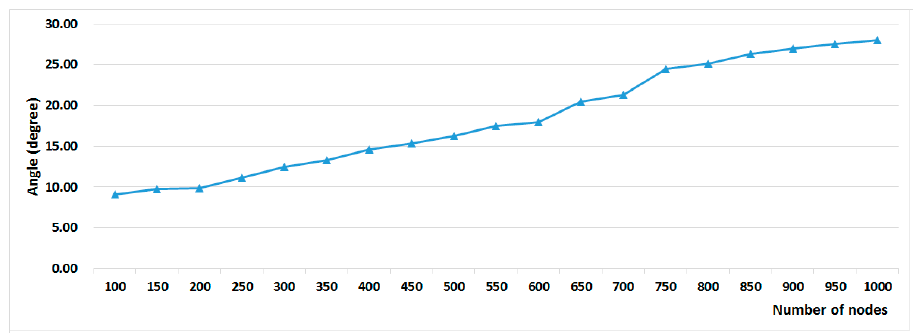
Figure 18. Optimal suppression angle varying with the number of vehicular nodes.